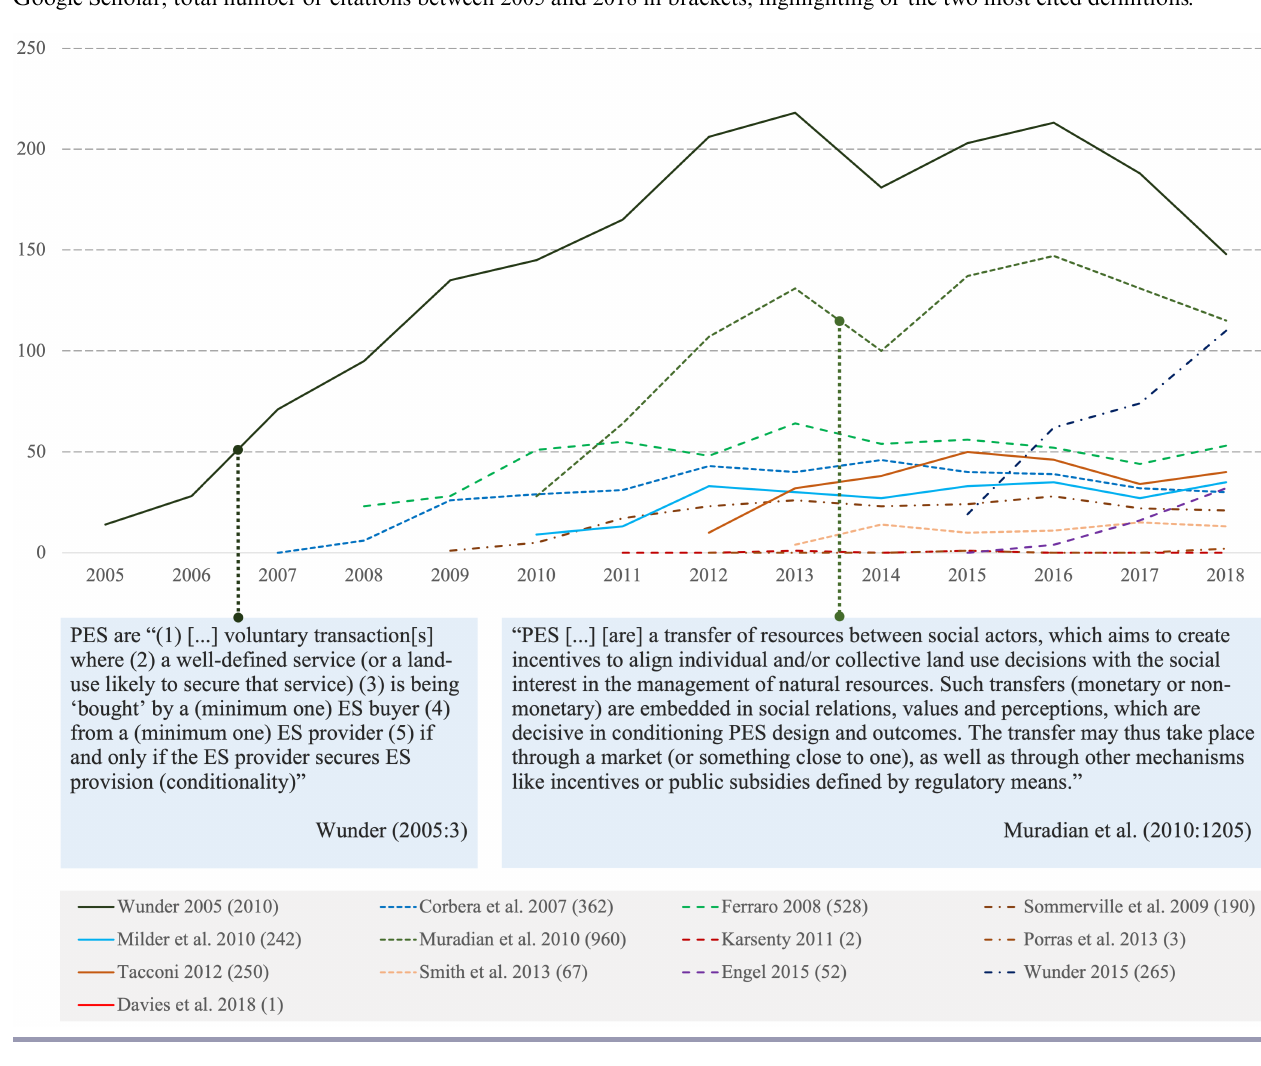
Fig. 2 . Number of citations of the publications containing the identified payments for ecosystem services (PES) definitions using Google Scholar; total number of citations between 2005 and 2018 in brackets; highlighting of the two most cited